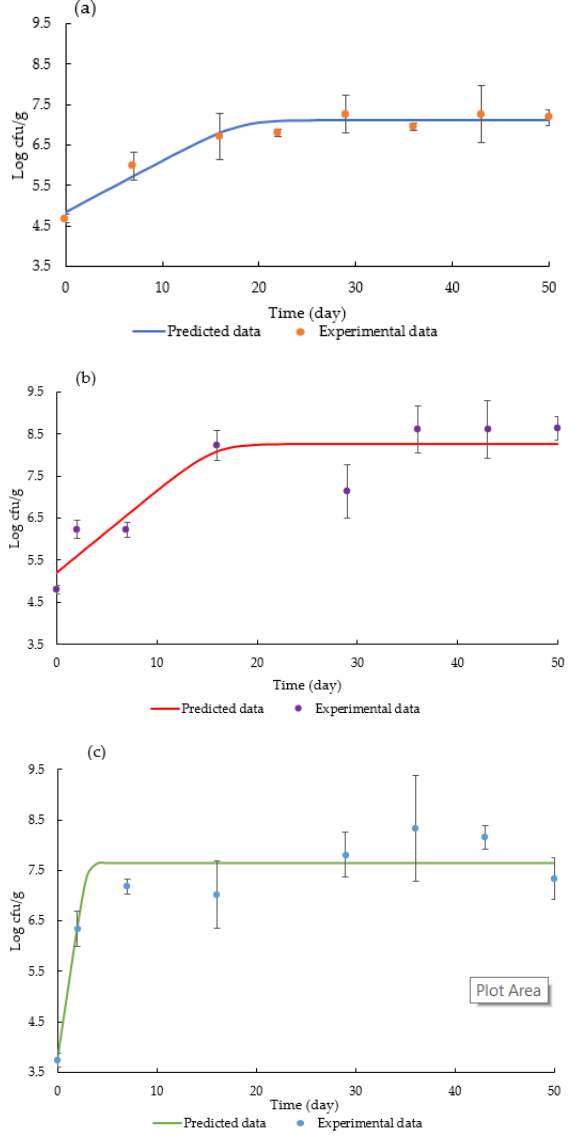
Figure 1. Fitting of the Baranyi model to the population of total viable counts of sausages stuffed in: ( a ) modified hog casings (MHC); ( b ) control hog casings (CHC); and ( c ) natural sheep casings (NSC).